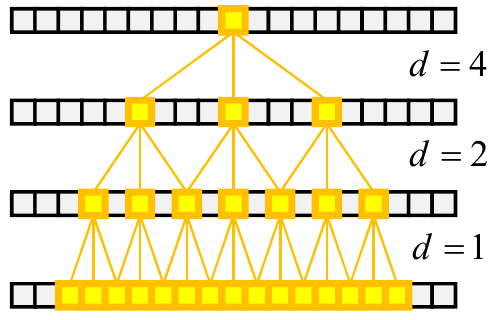
Figure 8. By stacking multiple layers of dilated convolution, deep neurons can obtain large receptive fields. The yellow squares are neurons that can be